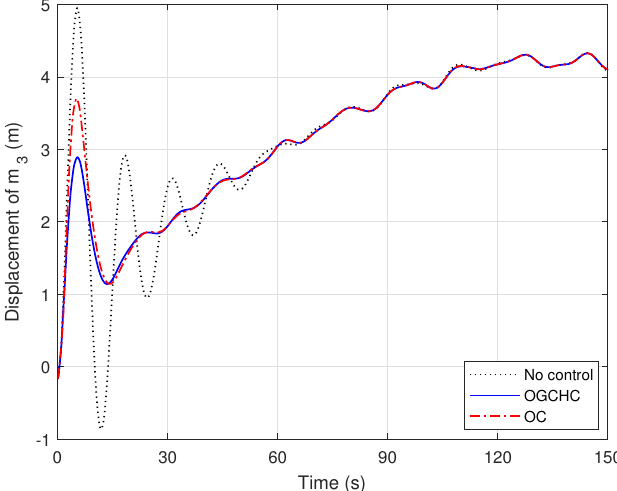
Figure 9. Displacement 3 of the riser without control, with OC and OGCHC under case II.